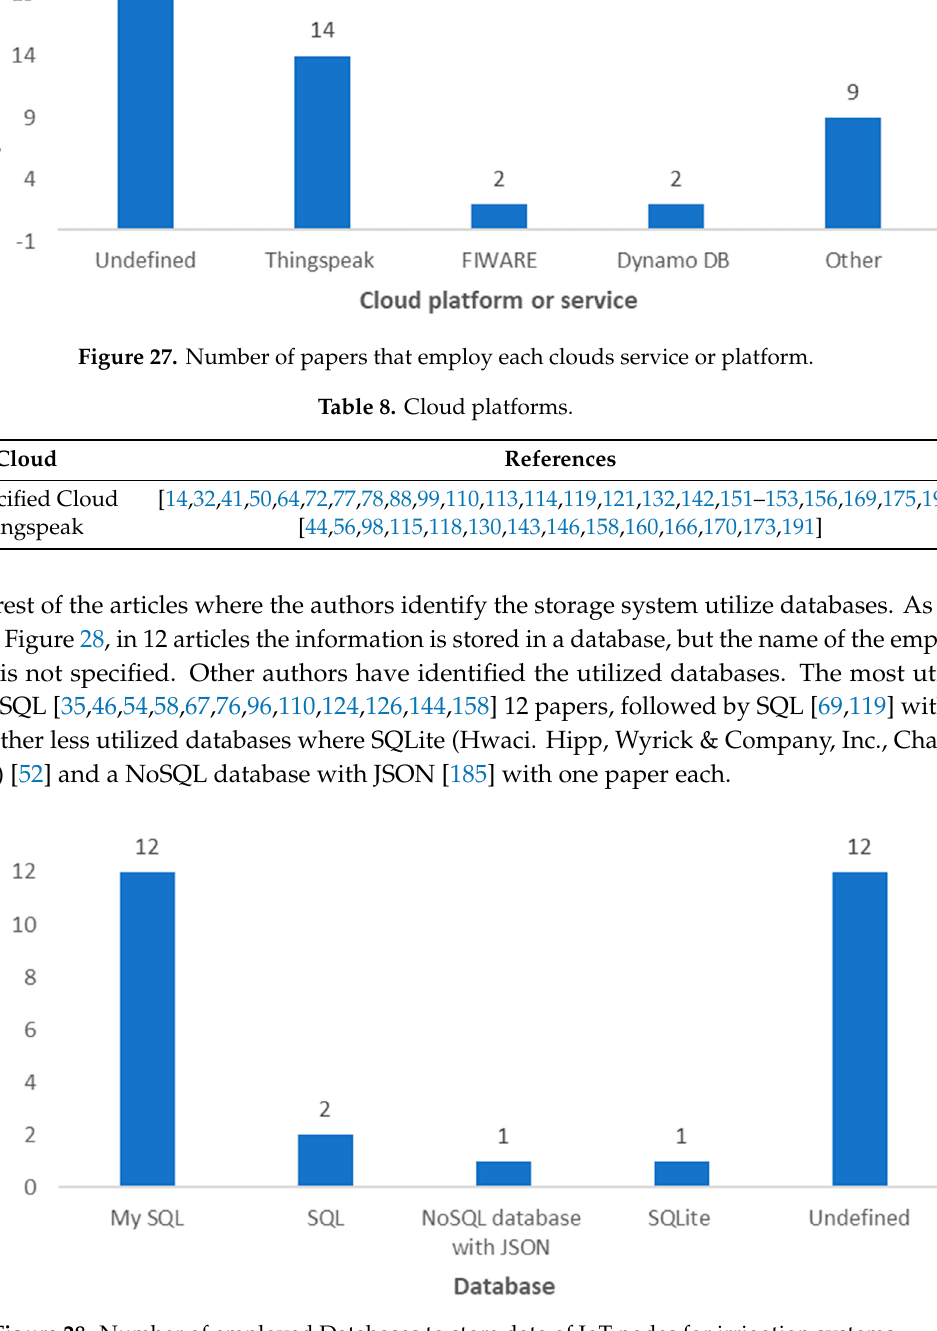
Table 8. Cloud platforms.